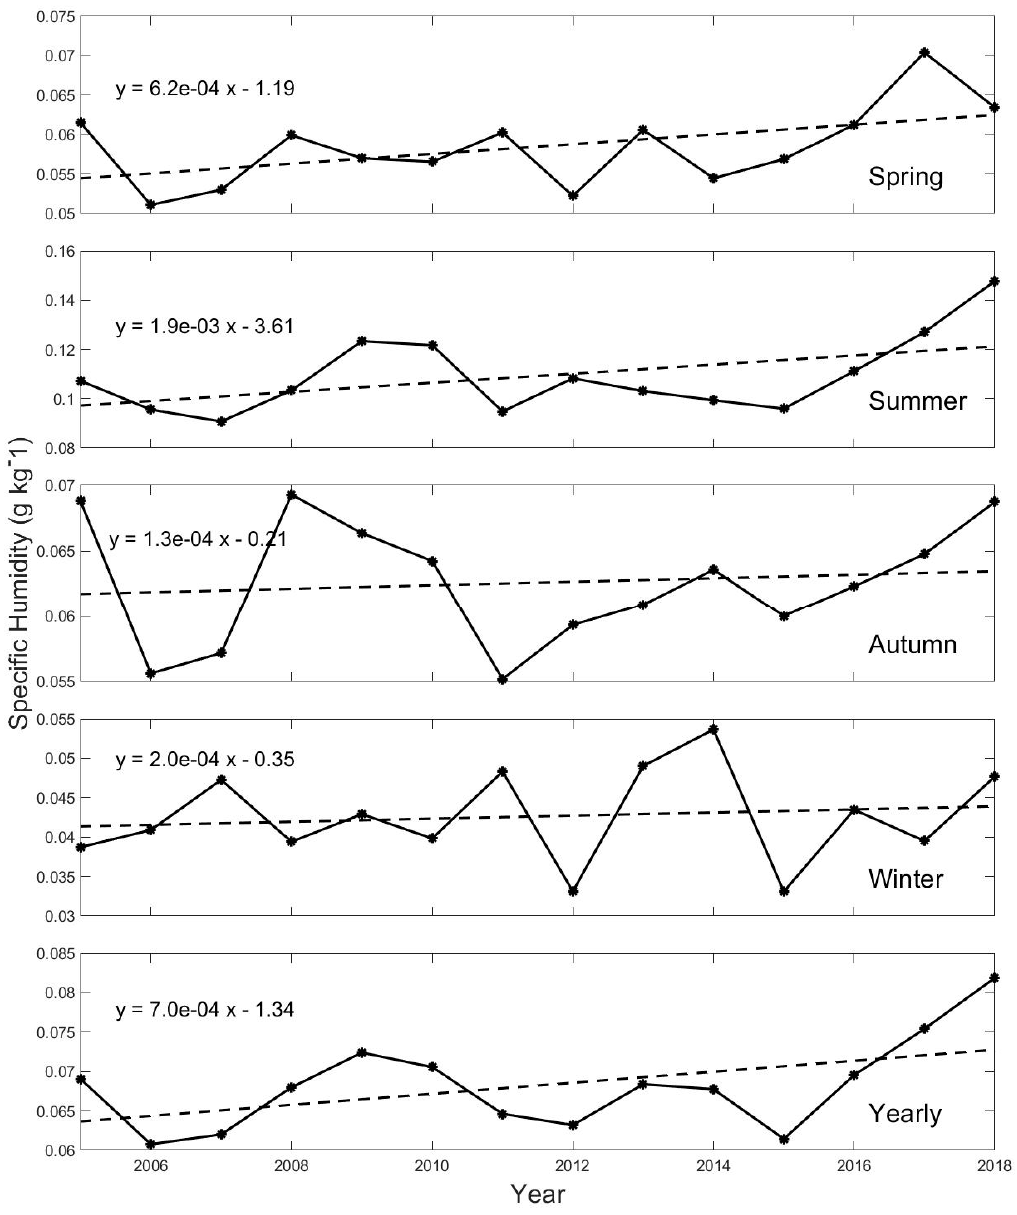
Figure 12. Same as Figure 5, but for specific humidity.